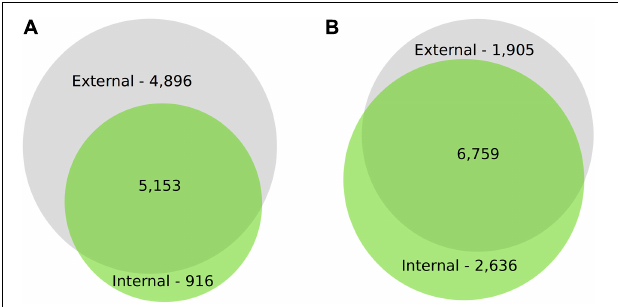
FIGURE 3 | There is substantial overlap in DEGs through time for cortex and peel. Proportional VENN Diagrams (www.biovenn.nl) showing: (A) Differential gene expression of the cortical tissues at 3m from internal fruit is largely a subset of differentially expressed gene from external canopy positions, (B) Differential gene expression of the peel tissues at 3m from internal fruit is proportional to external fruit, with substantial overlap. This suggests that the contrasting light environment of the two canopy positions has a larger effect on peel tissues, yet despite significant fruit flesh quality differences, DEGs from internal cortex is largely a subset of external DEGs. Significant differential expression was determined by Bonferroni corrected P < 0.05.